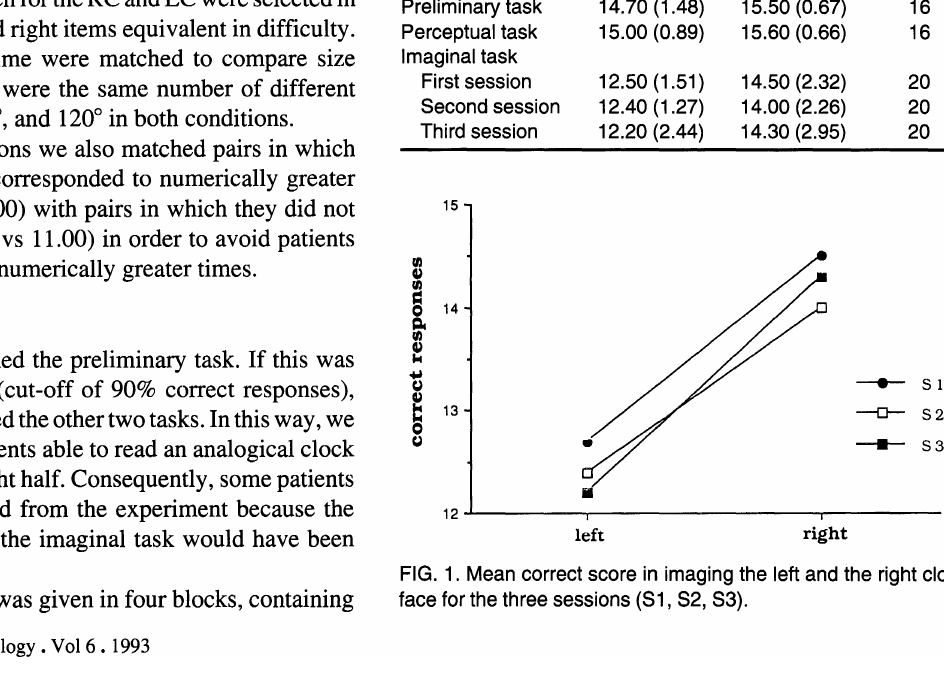
TABLE I. Mean correct scores of the patients Left condition Right condition Max. score ------- Preliminary task